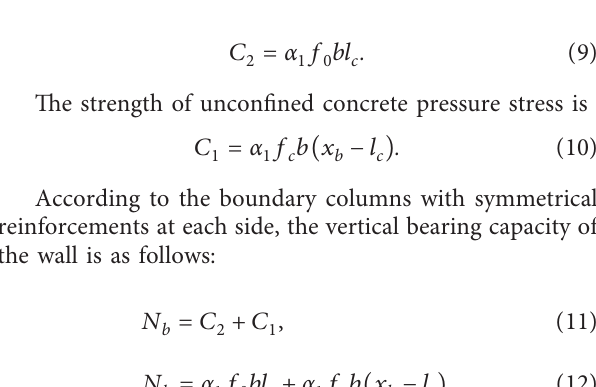
Figure 21: Calculation sketch of reinforced tenon joint precast shear wall. (a) Section size. (b) Strain distribution. (c) Steel stress. (d) Concrete